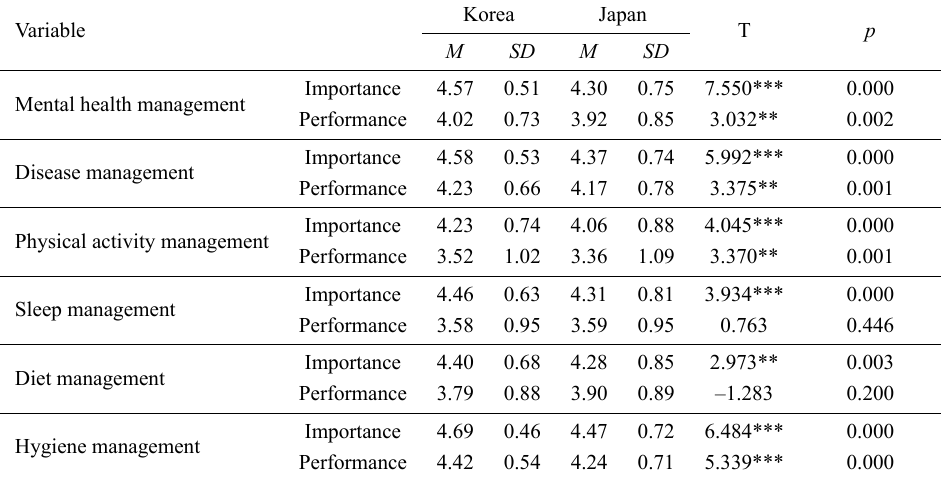
Table 3. Importance and performance comparisons between Korean and Japanese adolescent.